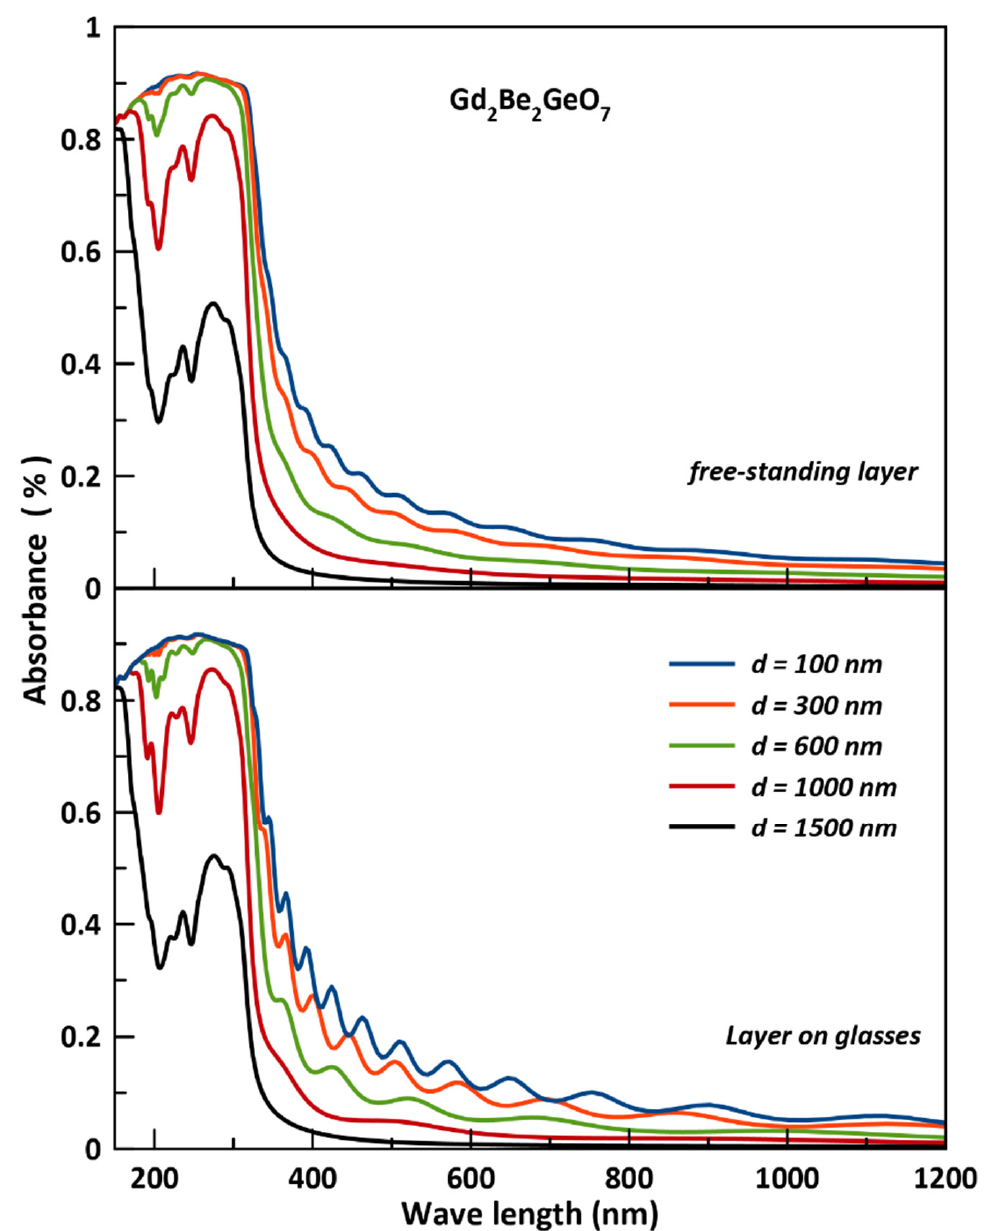
Figure 11. Absorbance spectra for Gd 2 Be 2 GeO 7 thin films with various thicknesses in both coating processes (free-standing layer and layer supported on glasses).